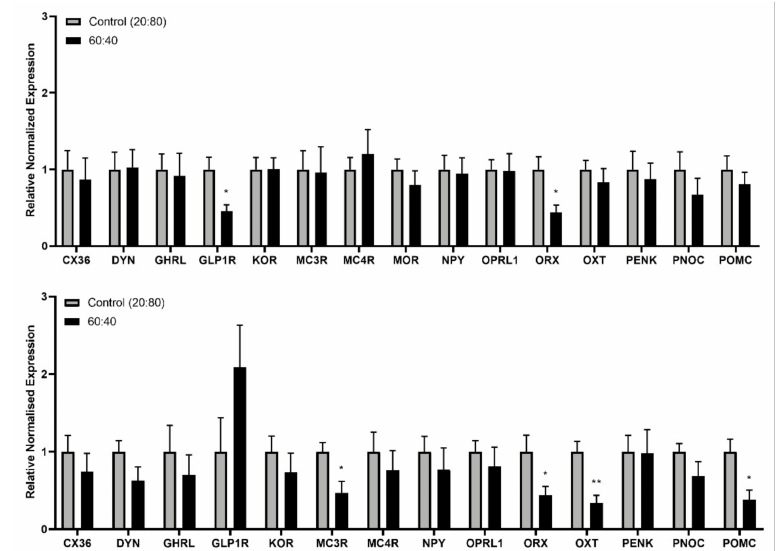
Figure 6. Relative expression of feeding-related genes in the hypothalamus ( top ) and brain stem ( bottom ) after 24-h consumption of the control 20:80 whey:casein formulation versus the 60:40 whey:casein test solution. * p ≤ 0.05; ** p ≤